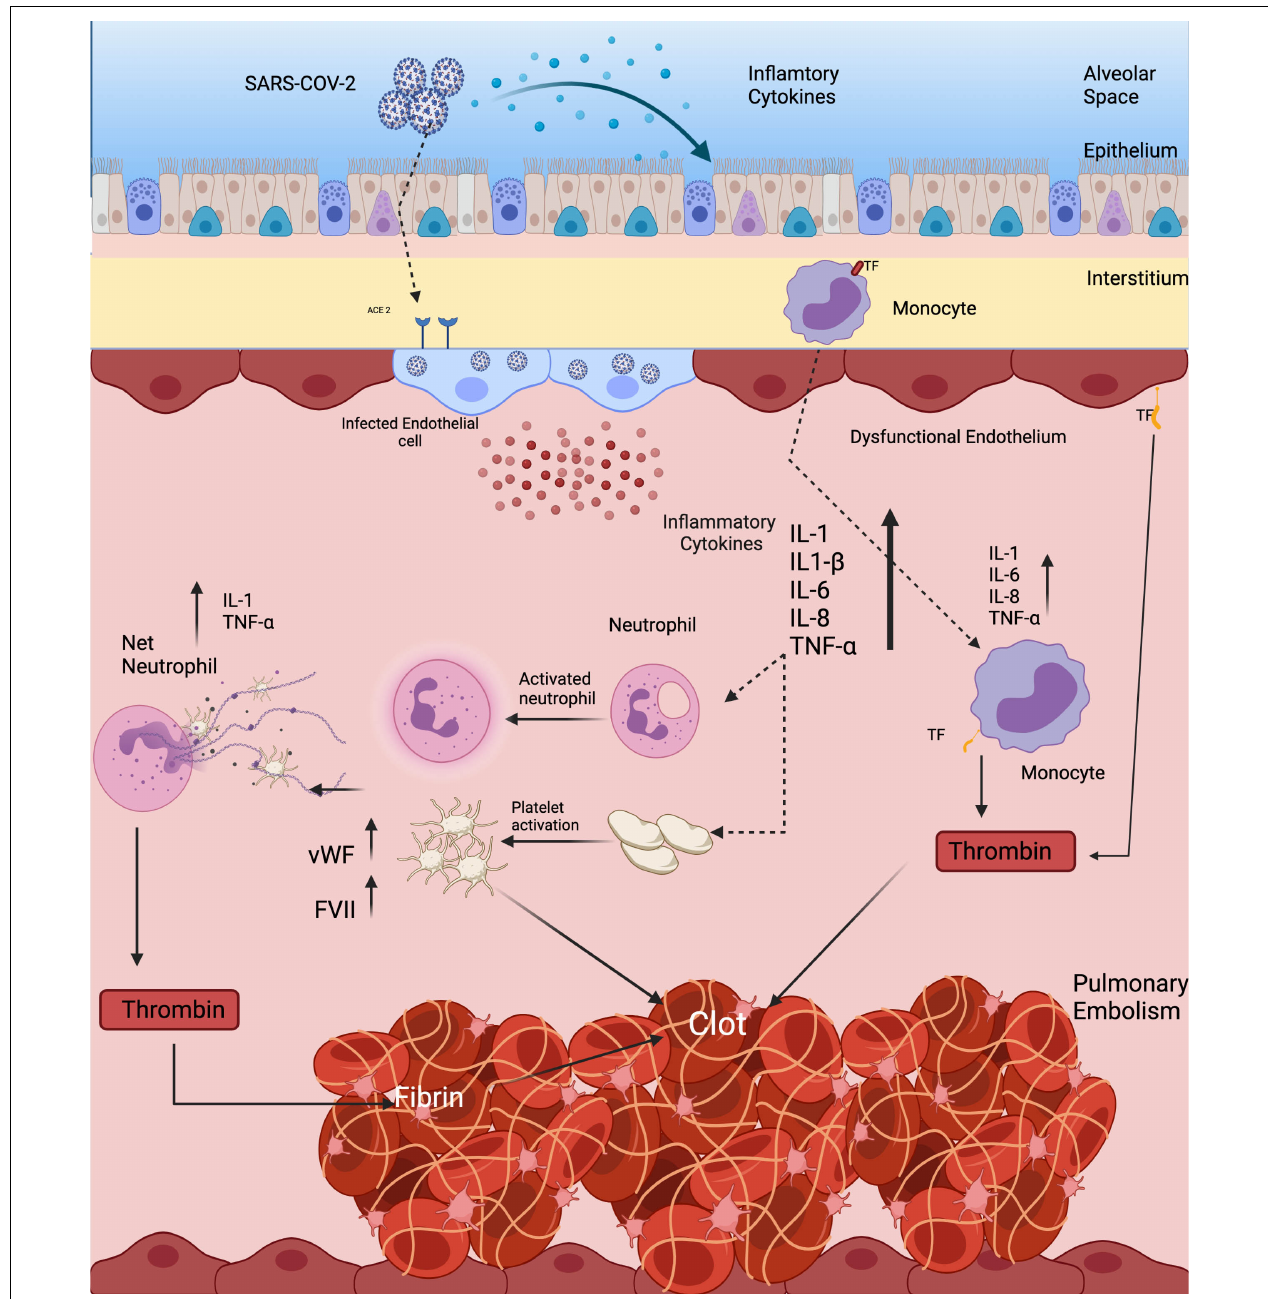
FIGURE 2 | Hypercoagulable state responsible for causing stroke and PE in SARS-CoV-2 virus. Direct infection of vascular endothelial cells through the ACE2 receptor leads to expression of TF, platelet activation, and increased levels of von Willebrand Factor and Factor VIII, all of which contribute to thrombin generation and fibrin clot formation. Platelet activation facilitates the creation of neutrophil extracellular traps. All of these inflammatory changes activate monocytes and leucocytes that contribute to a pro-thrombotic cytokine